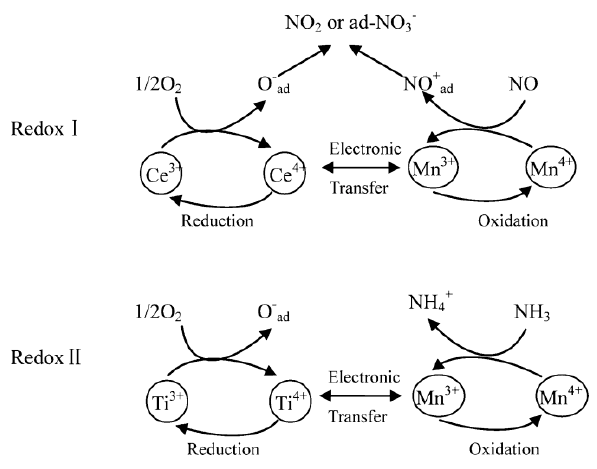
Figure 10. Dual redox cycles for the activation of NO and NH 3 [70].